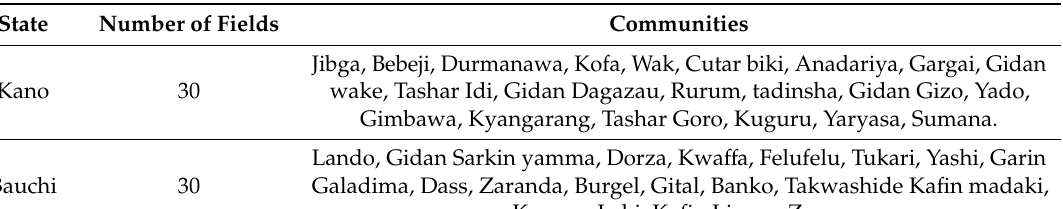
Table 1. On-farm locations in Kano and Bauchi States.